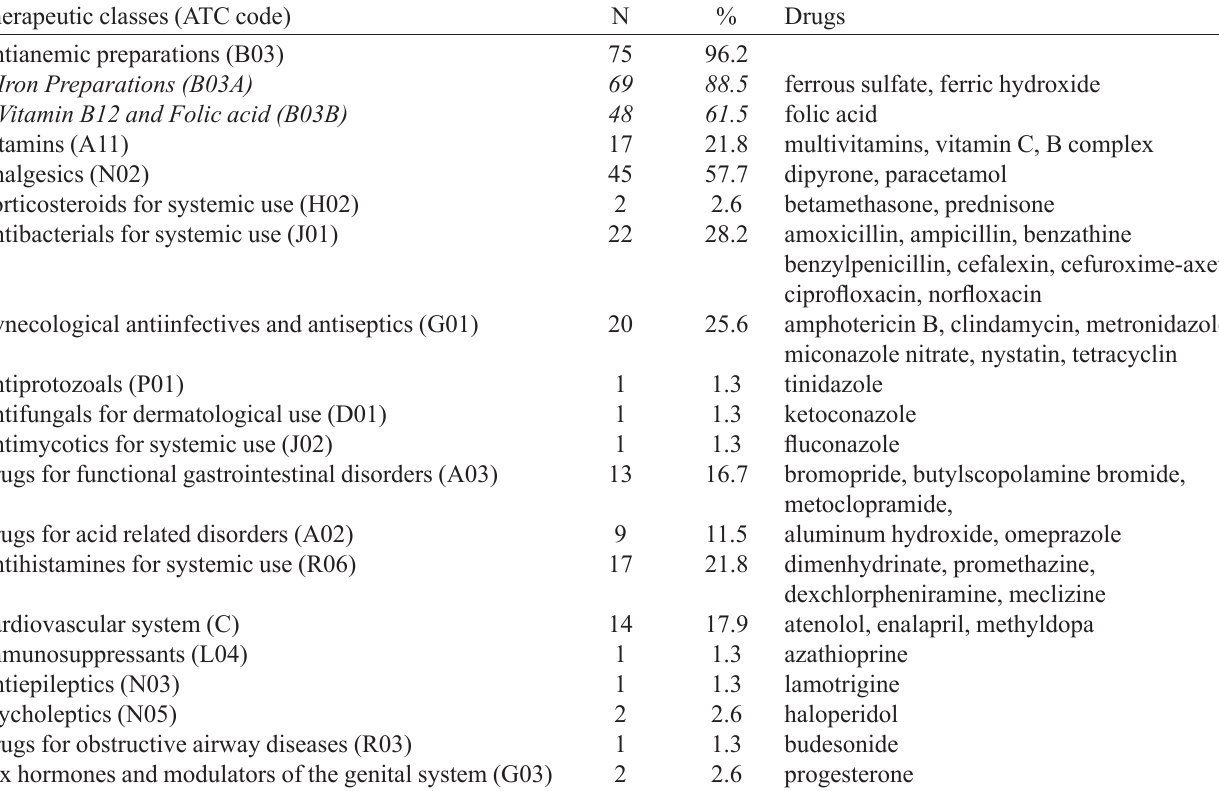
TABLE III – Distribution of prescribed drugs during gestation, according to the Anatomical Therapeutic Chemical Classification System (ATC), used by puerperal women interned in HC / UFPE after high-risk pregnancy, 2011 Therapeutic classes (ATC